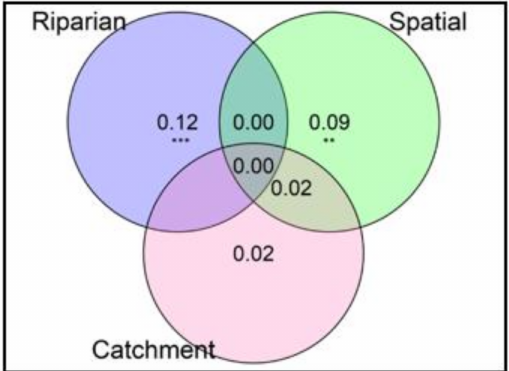
Figure 4. Variation partitioning results showing the portions of variation in the taxonomic structure of riparian invertebrate community explained by groups of predictors at nine paired sites in the Arges basin. Riparian = Buffer intactness scores, Spatial = PCNM1 and PCNM2 axes, Catchment , variables = % of Pasture. The unexplained (residual) variation was 75%; Values < 0 are not shown. ** p < 0.01, *** p <